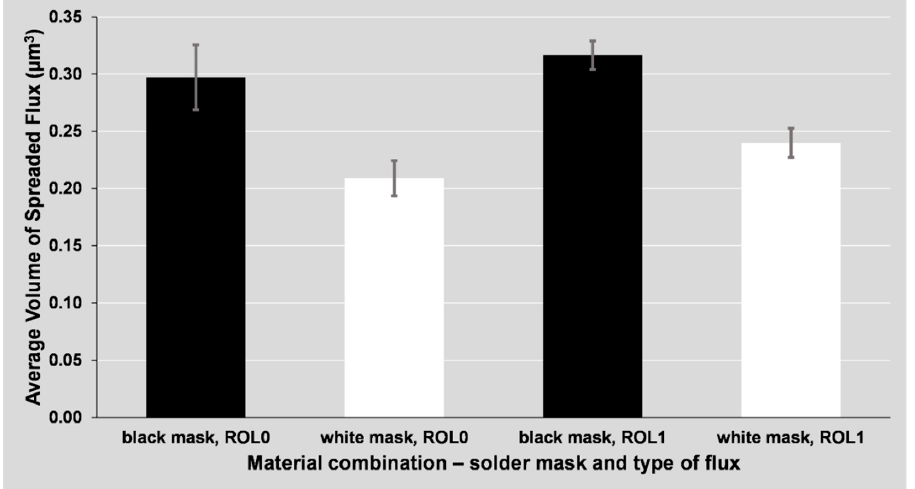
Figure 8. The average volume of spread flux around the soldering pad depending on the solder mask and flux type. The slight differences between the graphs in Figures 8 and 9 are given by the uneven